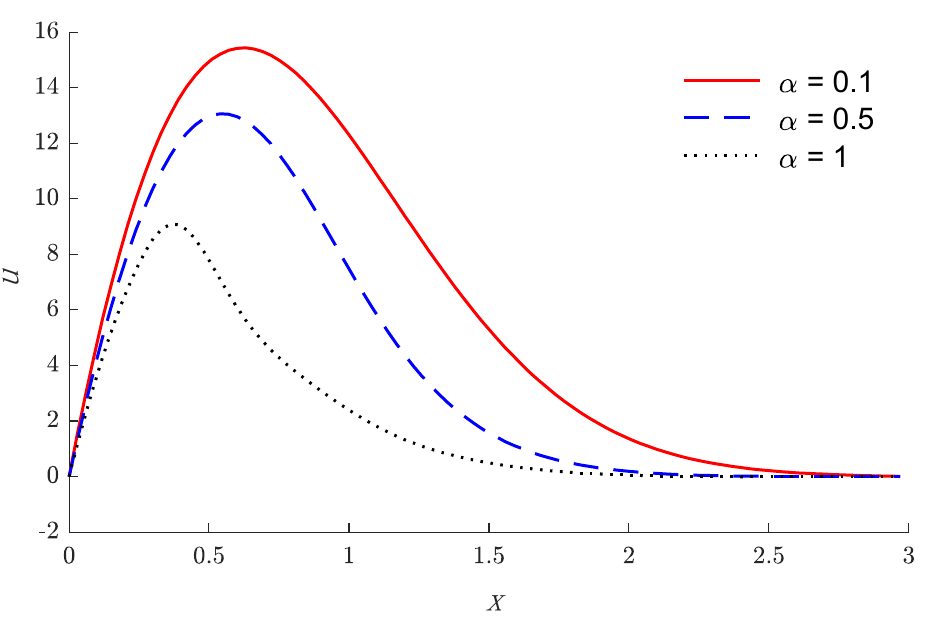
Figure 3. The displacement distributions via the distance x for three values of fractional parameters. When τ o = 0.05: